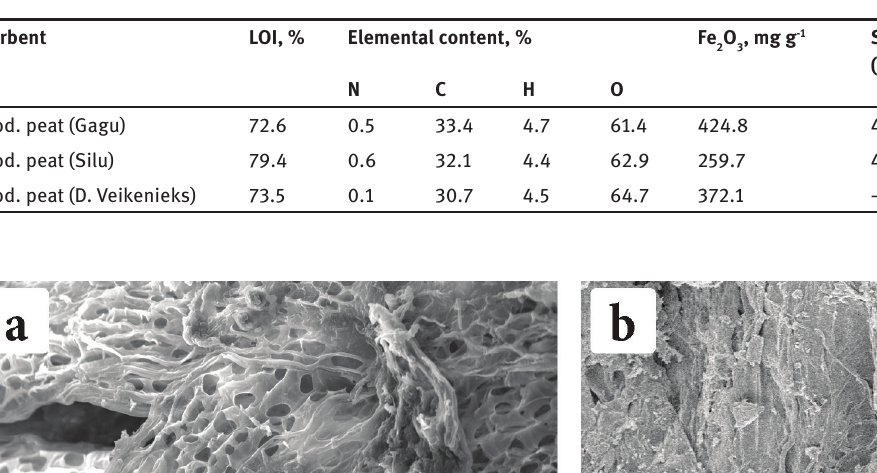
Table 1: Characterisation of sorbents.